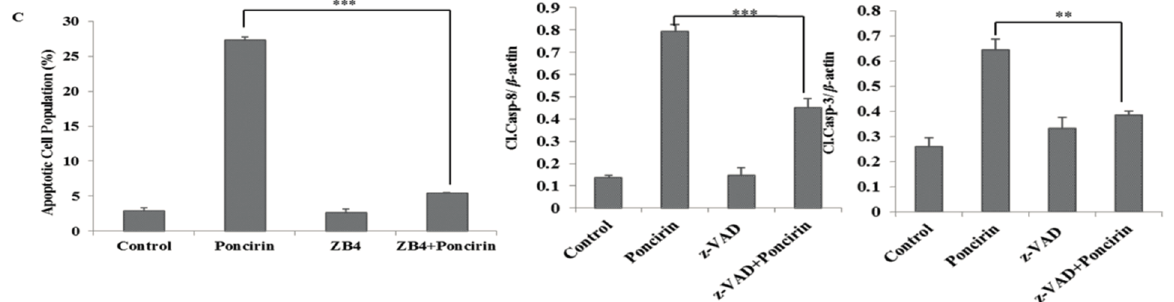
Figure 5. Poncirin activates extrinsic apoptosis pathway in AGS cells. ( A ) Cell viability